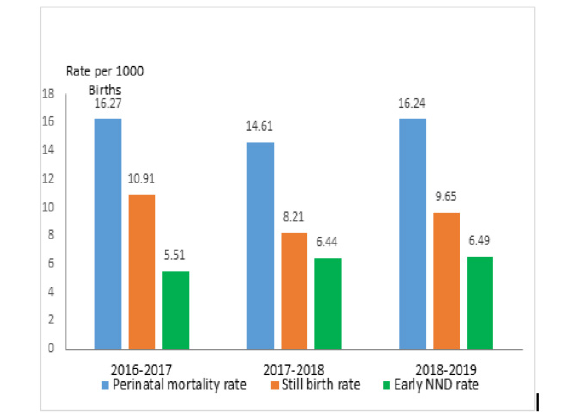
Figure 1: Bar diagram showing PMR, SB rate, and ENND rate of 2016 to 2019 All babies were born to women who had attended at least one antenatal care visit and 9 (45%) were born to mothers who had attended the recommended four antenatal care visits. 3 (15%) perinatal deaths occurred among booked patients and 17 (85%) amongunbooked patients.